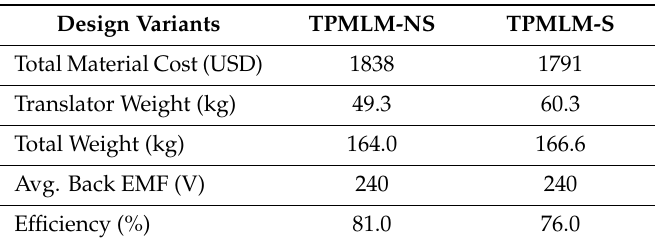
Table 4. Performance Comparison of the Optimized Proposed